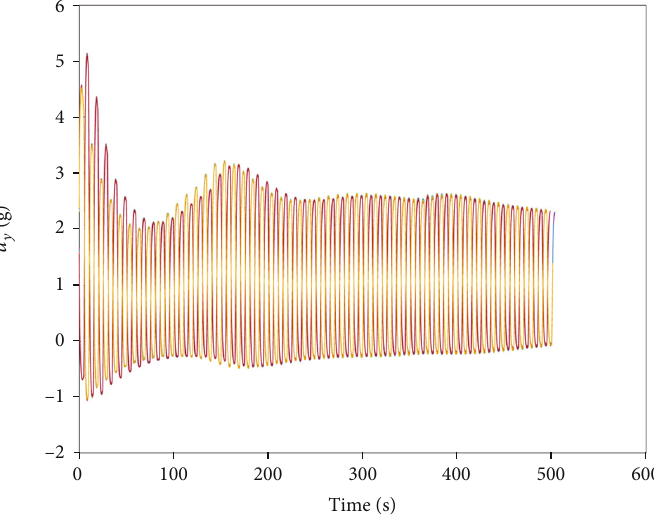
Figure 33: Normal accelerations in the Monte Carlo